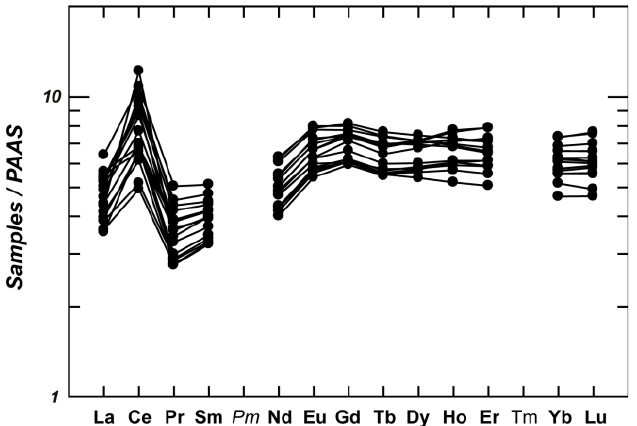
Figure 7. PAAS-normalised REE plots for selected hydrogenetic crusts.